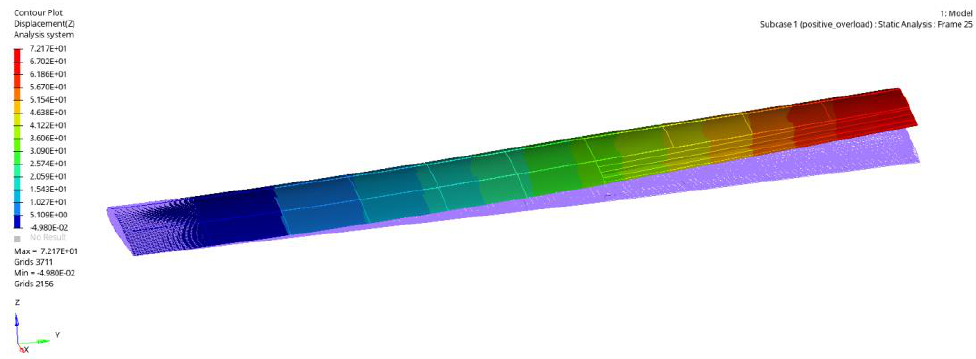
Figure 16. Z-direction displacement ( “ +2.5 G ” in condition A).